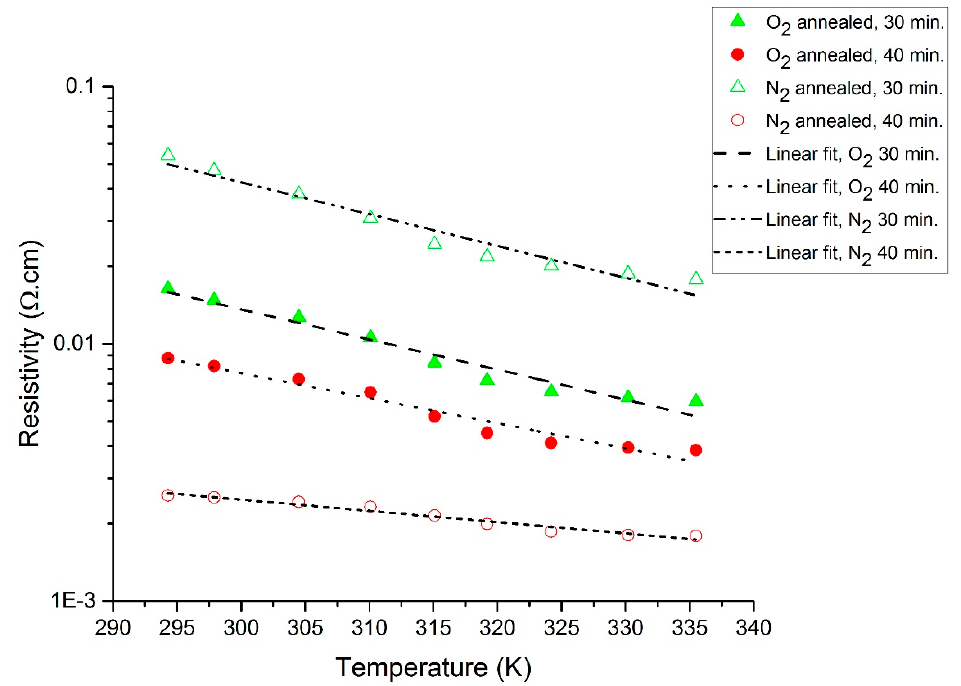
Figure 5. Resistivity (log scale) versus temperature plot for O 2 - and N 2 -annealed resistive thermometers.